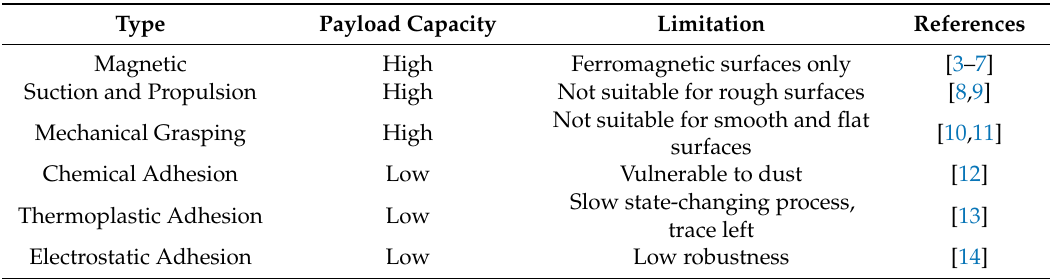
Table 2. Comparison of adhesion mechanisms.